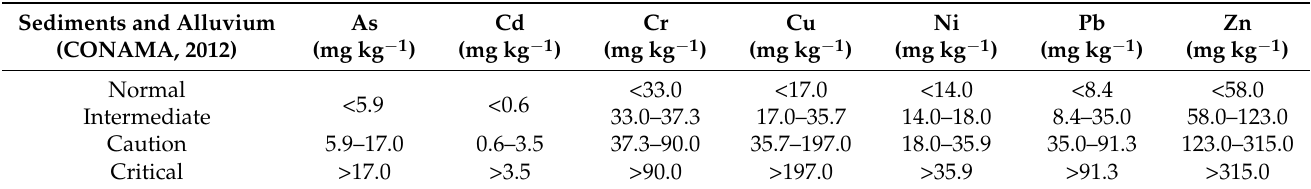
Table 2. Reference values for the quality of sediments and alluvium, according to guideline